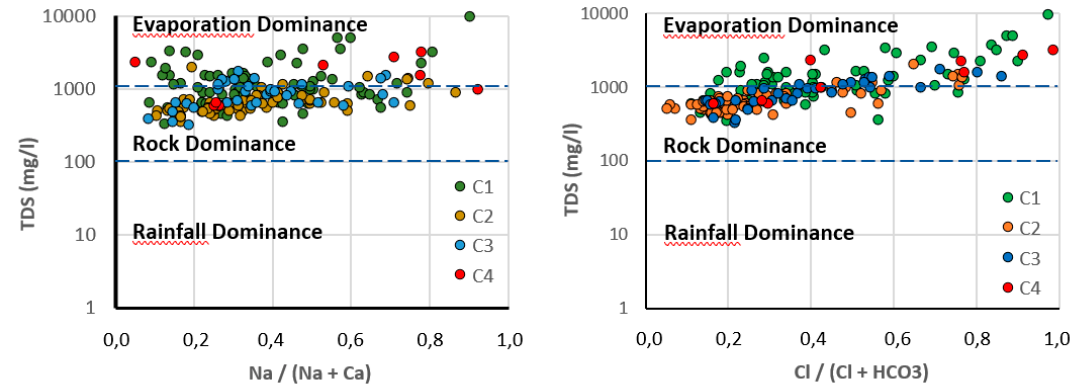
Figure 15. Plots of the water samples on Gibbs diagrams.